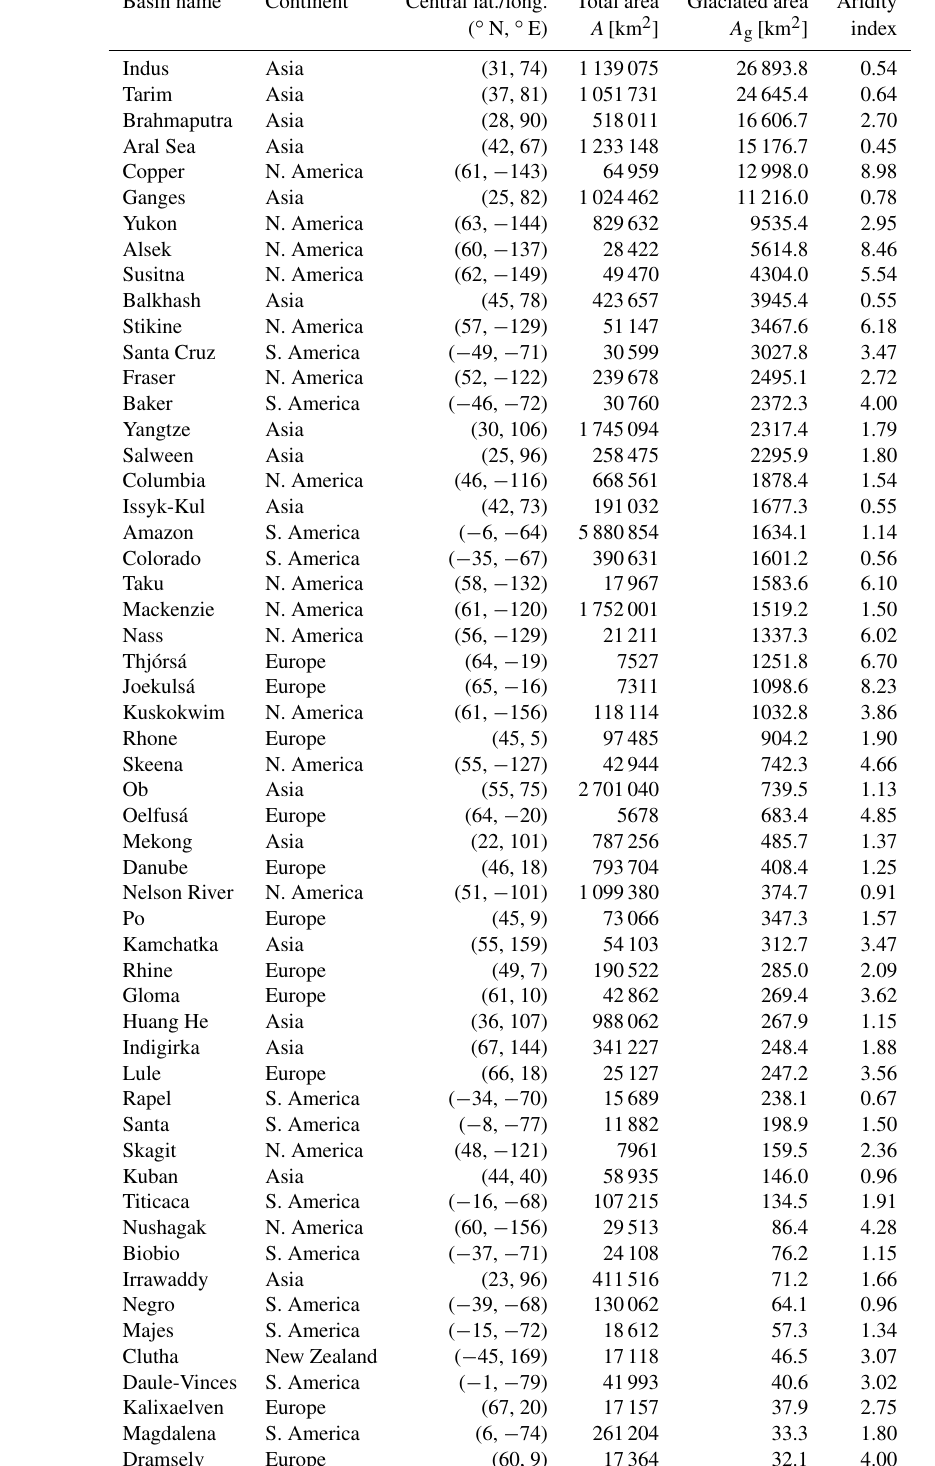
Table A1. Characteristics of the 56 basins studied, arranged in descending order of total glaciated area (matching Fig. A1). Total area A is based on the Global Runoff Data Centre (2007) basin outlines. Glaciated area A g per basin was provided by Matthias Huss, based on Randolph Glacier Inventory version 4.0 (RGI Consortium, 2014, updated 2017). Aridity index is a multi-GCM mean over the 1980–2010 historical